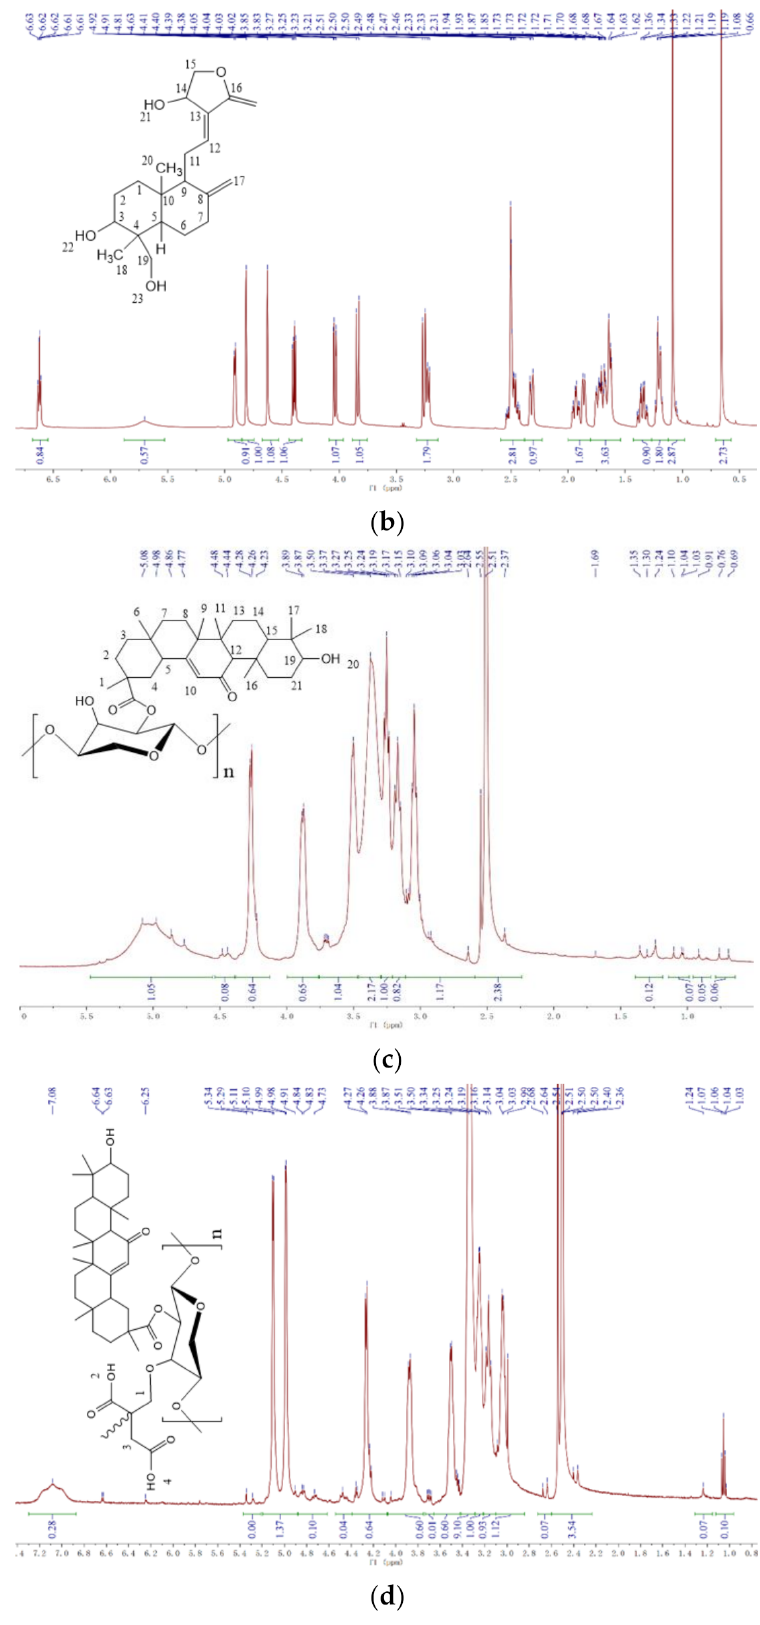
Figure 9. ( a ) The 1 H NMR spectra of BX. ( b ) The 1 H NMR spectra of AD. ( c ) The 1 H NMR spectra of GA-BX/AD.( d ) The 1 H NMR spectra of